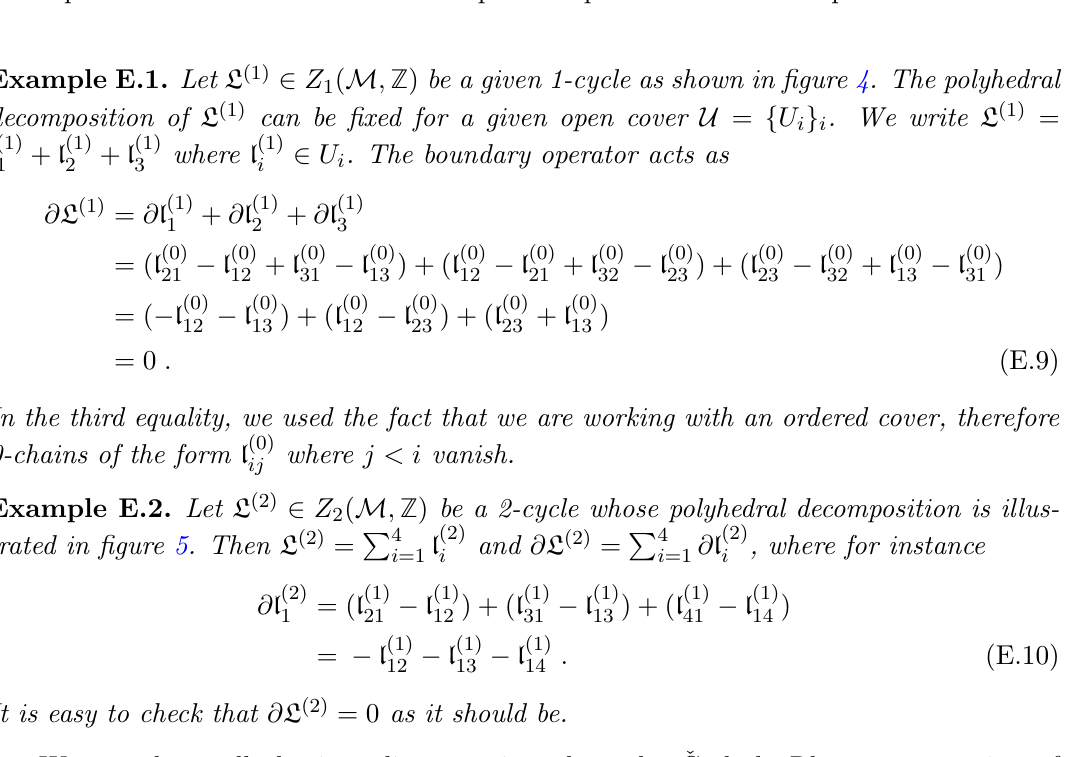
subordinate to a choice of l (1) i =1 i